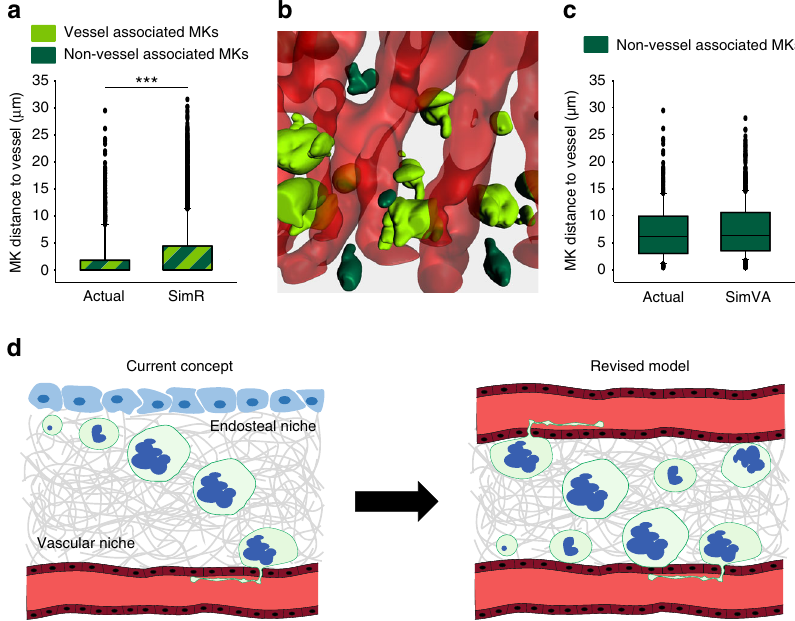
Fig. 7 MKs display a vessel-biased random distribution. MK distribution was simulated ( n = 6 simulations) using blood vessels ( red ) and MKs ( green ) derived from sternal BM imaging data. a The average distance of random distributed MKs to the vessel (SimR) is increased compared to actual data. *** p < 0.001. b Simulated vessel-associated MKs are depicted in light green , non-vessel-associated MKs are depicted in dark green . c Random simulation of only the non-vessel associated MK population results in average distances comparable to those obtained by 3D imaging data. d According to the current model of megakaryopoiesis ( left panel ), blood cell precursors migrate from the endosteal niche towards the vessel sinusoids during maturation. Our data support a revised model ( right panel ) where MKs reside directly at the sinusoids and are replenished by precursors originating from the sinusoidal niche rather than a periostic 3D environment. For modeling, the morphology and size of the but displays a vessel-biased distribution (Fig. 7a). The SimR MKs, as well as the BM vasculature, were derived from isosurfaces simulation predicts signi fi cantly larger MK-vessel distances and of experimental data, thus accurately re fl ecting the physiological a lower percentage of vessel-associated MKs (62.8 ± 1.9% situation spatially. The MK-like objects were randomly placed compared to 70.1% in experimental data). Next, in a modi fi ed into the BM, however a fully random MK distribution (SimR) did simulation, we only considered the MK subpopulation of the not re fl ect the distribution from our 3D imaging results (Fig. 7a). NVA MKs (SimVA, dark green in Fig. 7b) to be random. To this The MK population in vivo is not randomly distributed, end, the BM vasculature with its vessel associated MKs was used